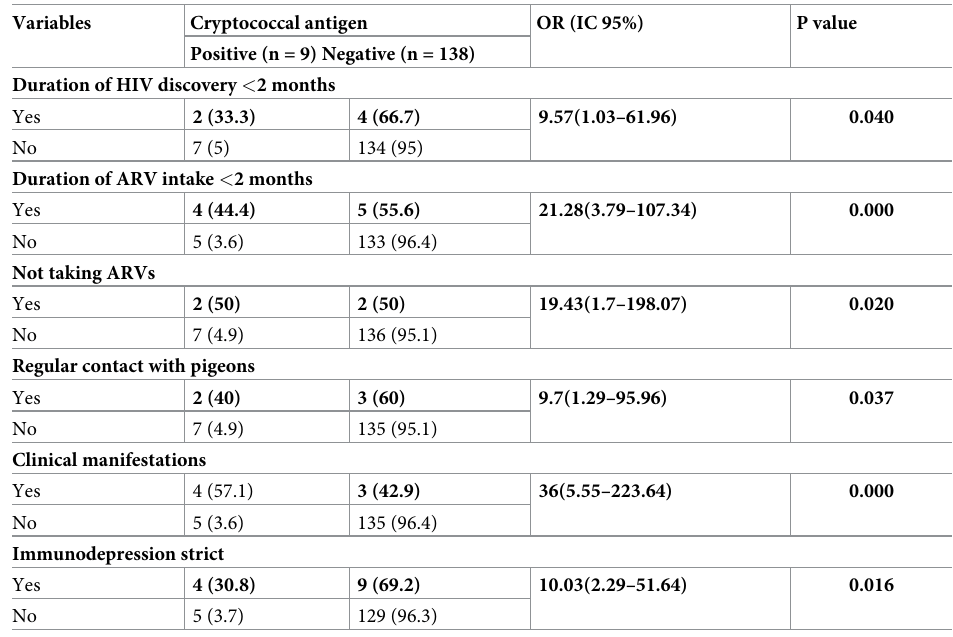
Table 5. Multivariable analysis of factors associated with carriage of cryptococcal